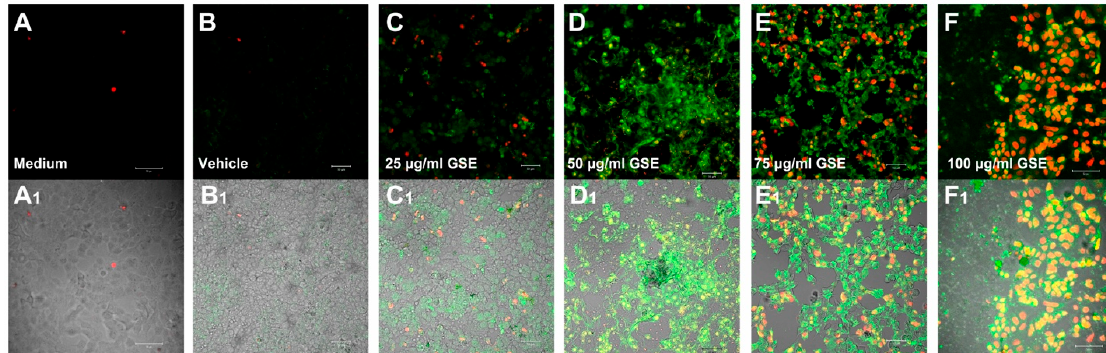
Figure 2. Confocal images of apoptosis detected by labelling with Alexa Fluor ® 488-conjugated Annexin V (green) and propidium iodide (red), in MCF-7 cells treated with 25, 50, 75 and 100 μ g of GAE/mL GSE for 24h and compared with untreated cells (medium) and cells treated with 0.025% acetonitrile as vehicle control (vehicle). ( A – F ) are the matching images from red and green channel fluorescence detectors; A1-F1, combination with the transmitted light images. Images shown are representative of three independent experiments, each done in quadruplicate. Bar is 50 μ m.